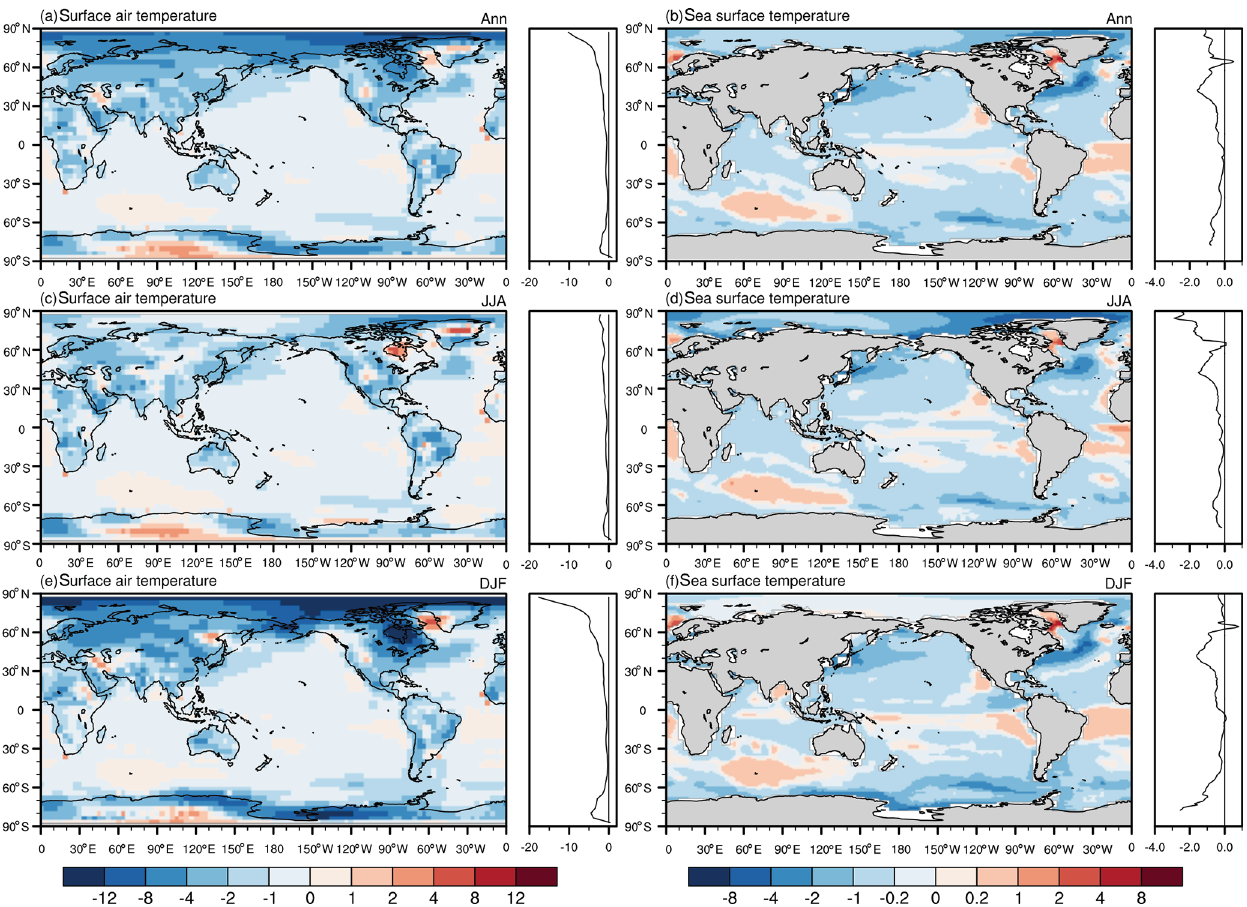
Figure 9. Anomalies of surface air temperature change (a, c, e) and sea surface temperature change (b, d, f) (units: ◦ C) between PlioMIP2 and PlioMIP1 (PlioMIP2 minus PlioMIP1) according to NorESM-L for the annual means (a, b) , boreal summer (c, d) , and boreal winter (e, f) . The zonal mean is shown to the right of each